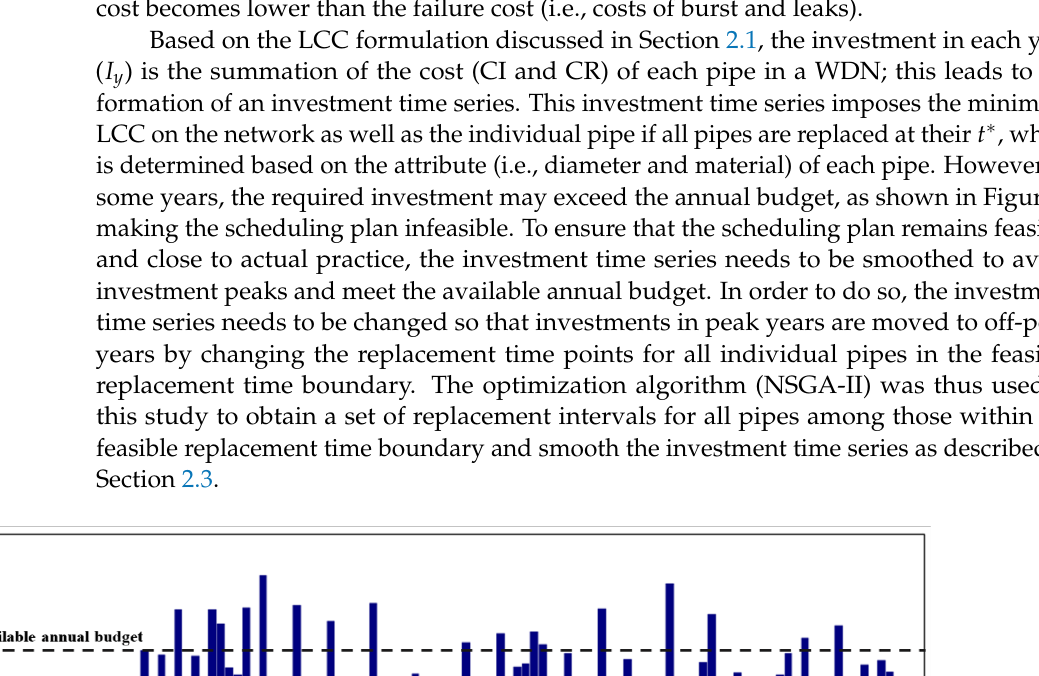
Figure 2. Selection of replacement time interval based on LCC curve.